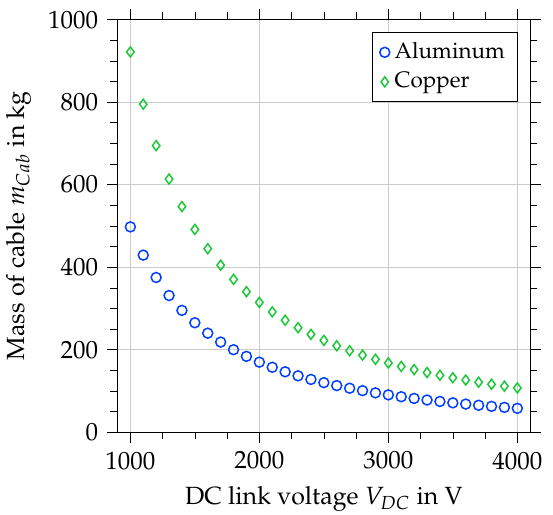
Figure 6. Cable mass m Cab vs. varying DC link voltage V DC of the DC power transmission cable ( P Inv , DC = 1.0MW, T Cab = 120 ◦ C and L Cab = 86.0m). With increasing DC link voltage level V DC , the cable mass decreases roughly